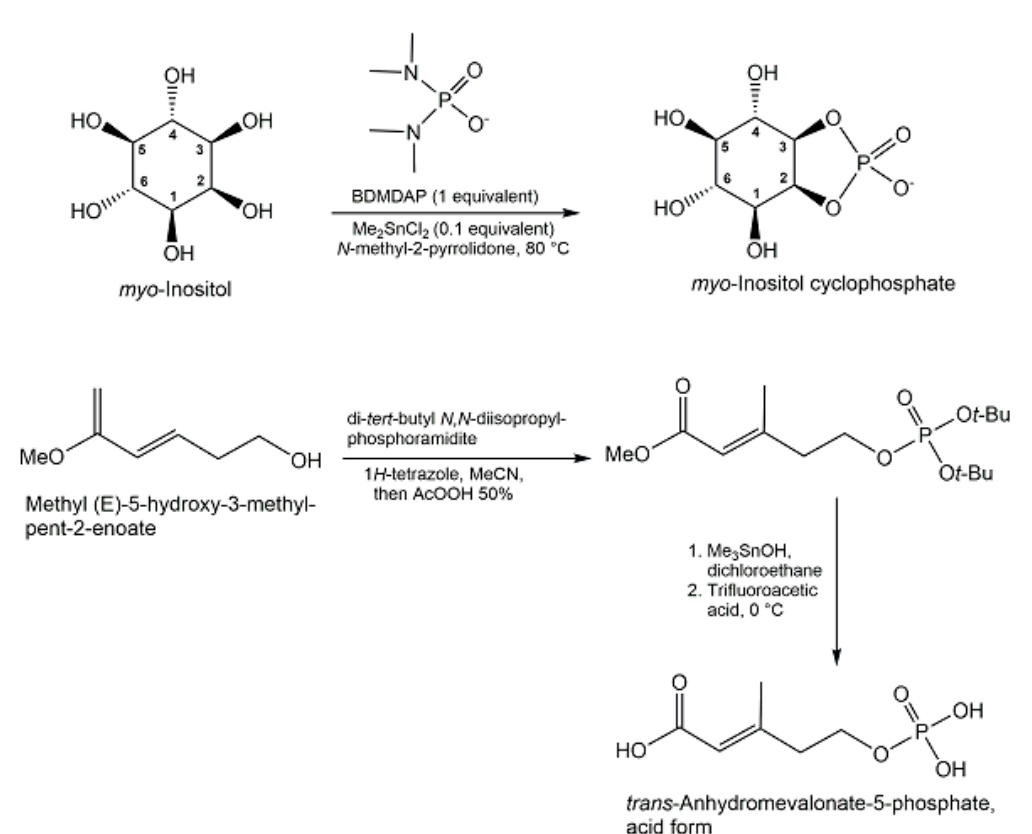
Figure 15. Chemical syntheses of myo -Inositol cyclophosphate, and trans -Anhydromevalonate-5- phosphate.